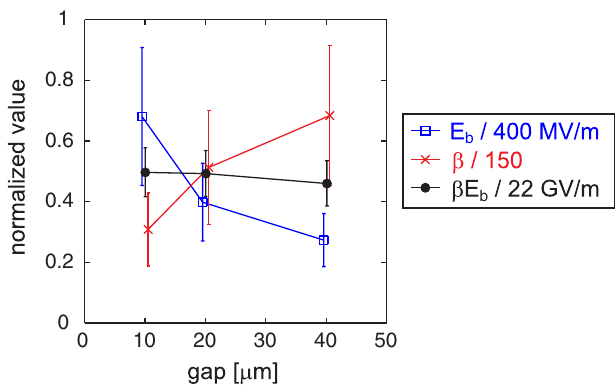
FIG. 5. (Color) Effect of the gap distance (10, 20, and 40 (cid:2) m ) on the average values of E b , (cid:1) and of the local breakdown field. For clarity, values are normalized to 400 MV = m , 150, and 22 GV = m , respectively.